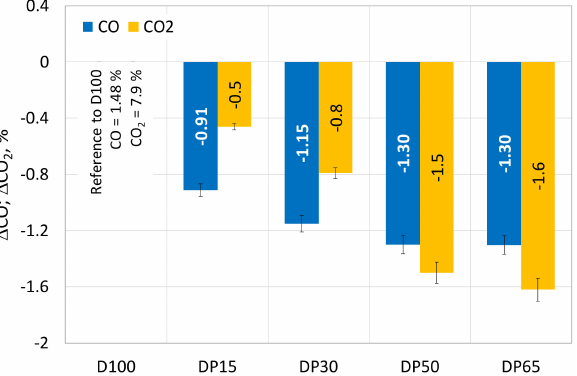
Figure 10. Emission of CO and CO 2 for dual-fuel engine fueled by diesel and